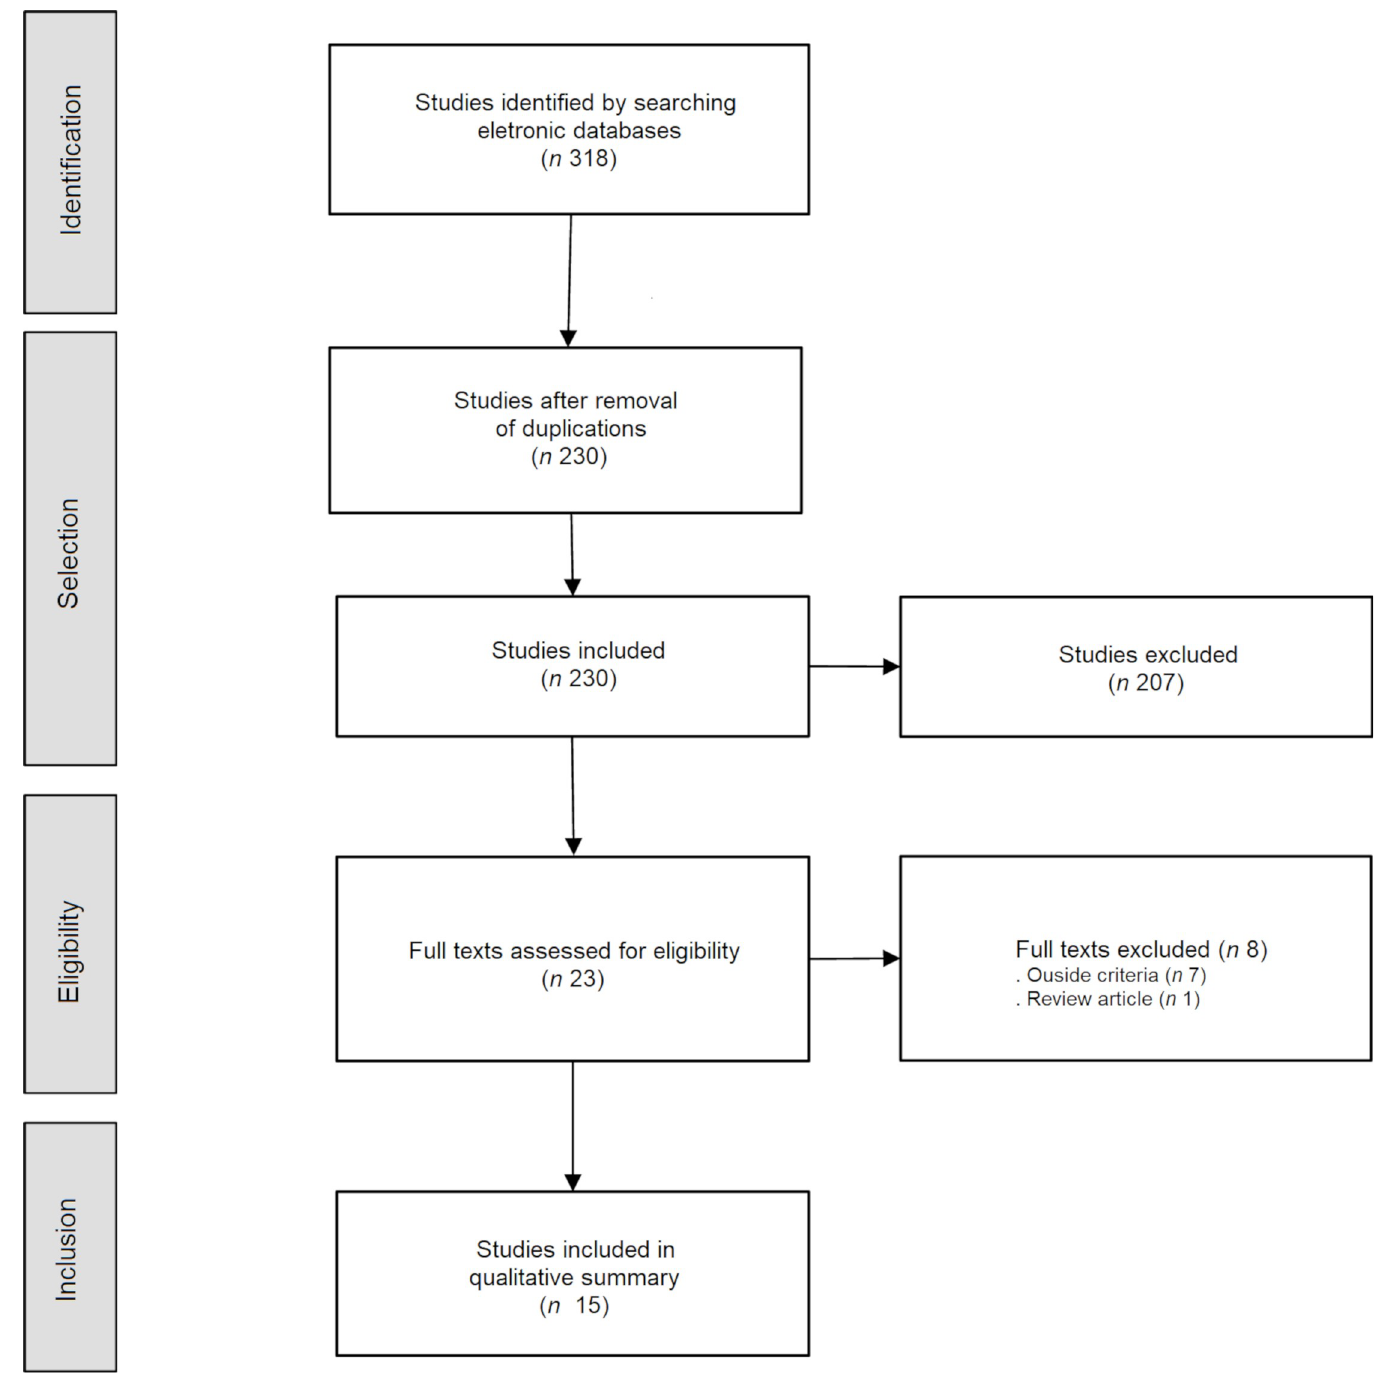
Fig 1. Flowchart of the study selection